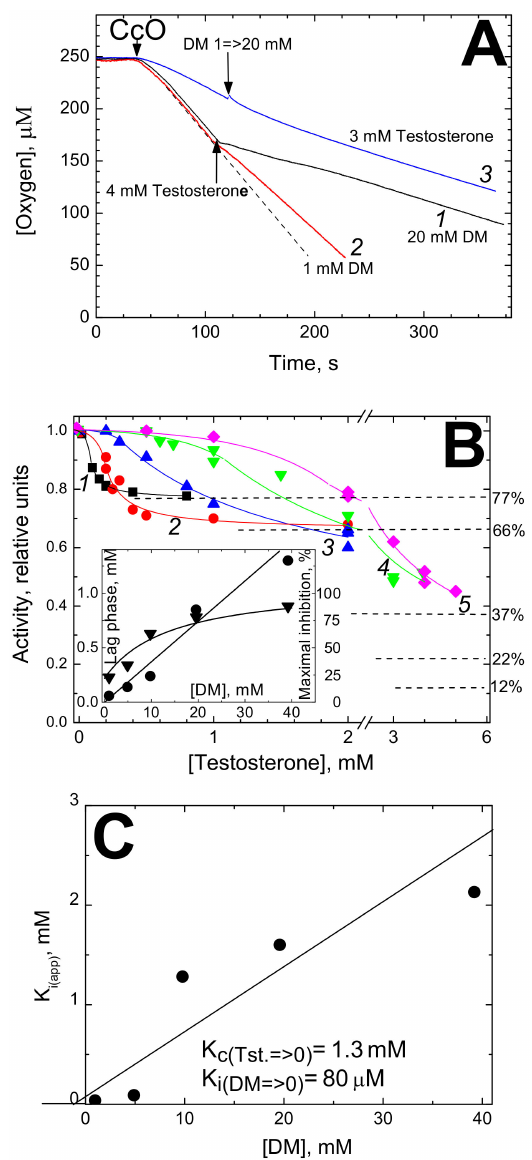
Figure 2. Inhibition of cytochrome c oxidase activity by testosterone. ( A ) Oxygraph traces. Basic conditions as in Figure 1A. The initial DM concentrations are: trace 1 (black)—20 mM, traces 2 (red) and 3 (blue)—1 mM. Trace 3 —the medium was also supplemented with 3 mM testosterone. Other additions are indicated by the arrows. The dashed straight line is drawn to visualize the e ff ect of testosterone at 1 mM DM. ( B ) Titrations of CcO activity by testosterone at di ff erent concentrations of DM. The DM concentrations were: 1 (black squares)—1 mM; 2 (red circles)—5 mM; 3 (blue triangles)—10 mM; 4 (green triangles)—20 mM; 5 (magenta diamonds)—40 mM. Other conditions are mostly as in Figure 1B. Theoretical curves described by hyperbolic function (see the text) are drawn through the experimental points in the range of testosterone concentrations above the lag-phase value. For the lower concentrations of the inhibitor, the experimental points are connected by empirical lines simply to guide the eye. Dependences of the lag-phase length (filled circles, the left-hand Y axis) and of maximal inhibition level (filled triangles, the right-hand Y axis) on DM concentration are shown in the Inset. ( C ) Dependence of an apparent K i for testosterone on DM concentration. The true value of K i for testosterone (Tst.) in the absence of DM and K c (dissociation constant) for DM in the absence of testosterone can be graphically determined as in the case of estradiol (see Figure